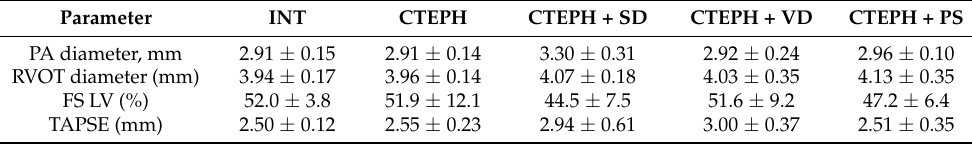
Table 2. Echocardiographic parameters 6 weeks after the last administration of